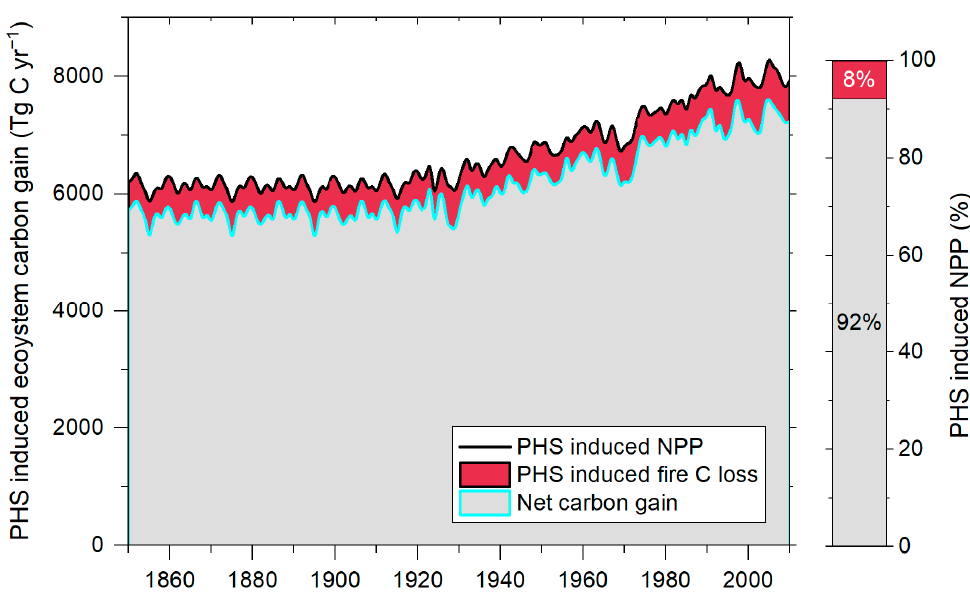
Figure 7. PHS-induced (Delta) fire carbon loss versus ecosystem carbon gain (i.e., net primary productivity, NPP).